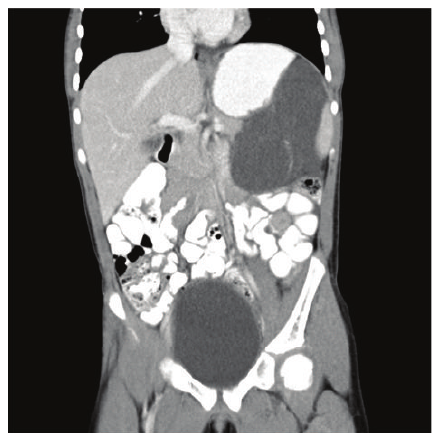
Figure 2: Contrast-enhanced CT coronal scan shows retroperi- toneal lobulated-septated cystic mass that reaches to subdiaphrag- matic space.